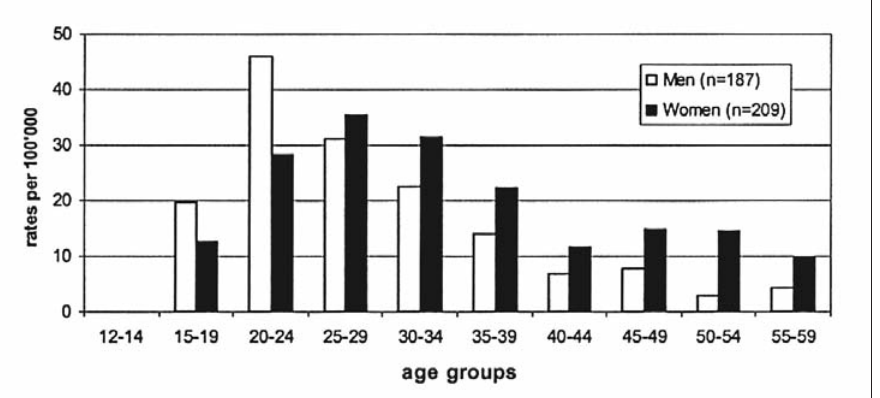
Sex-specific age- distribution of first admissions because of schizophrenia